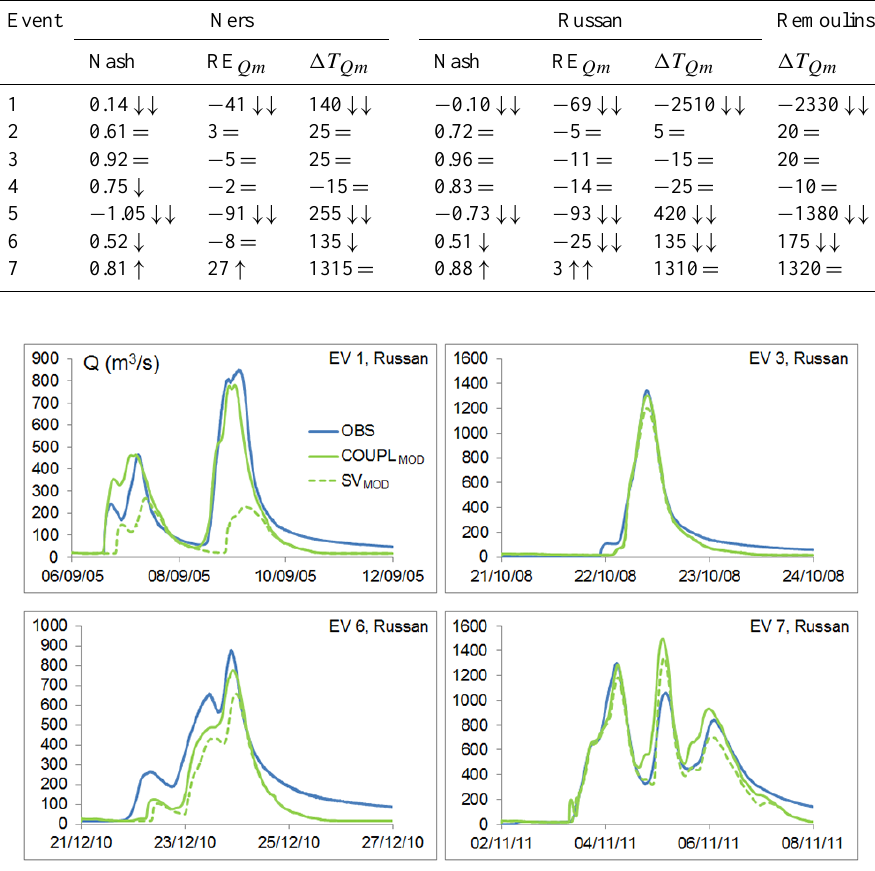
Figure 6. Hydrographs modelled for event nos. 1, 3, 6 and 7 according to the COUPL MOD and SV MOD modelling options, at the Russan